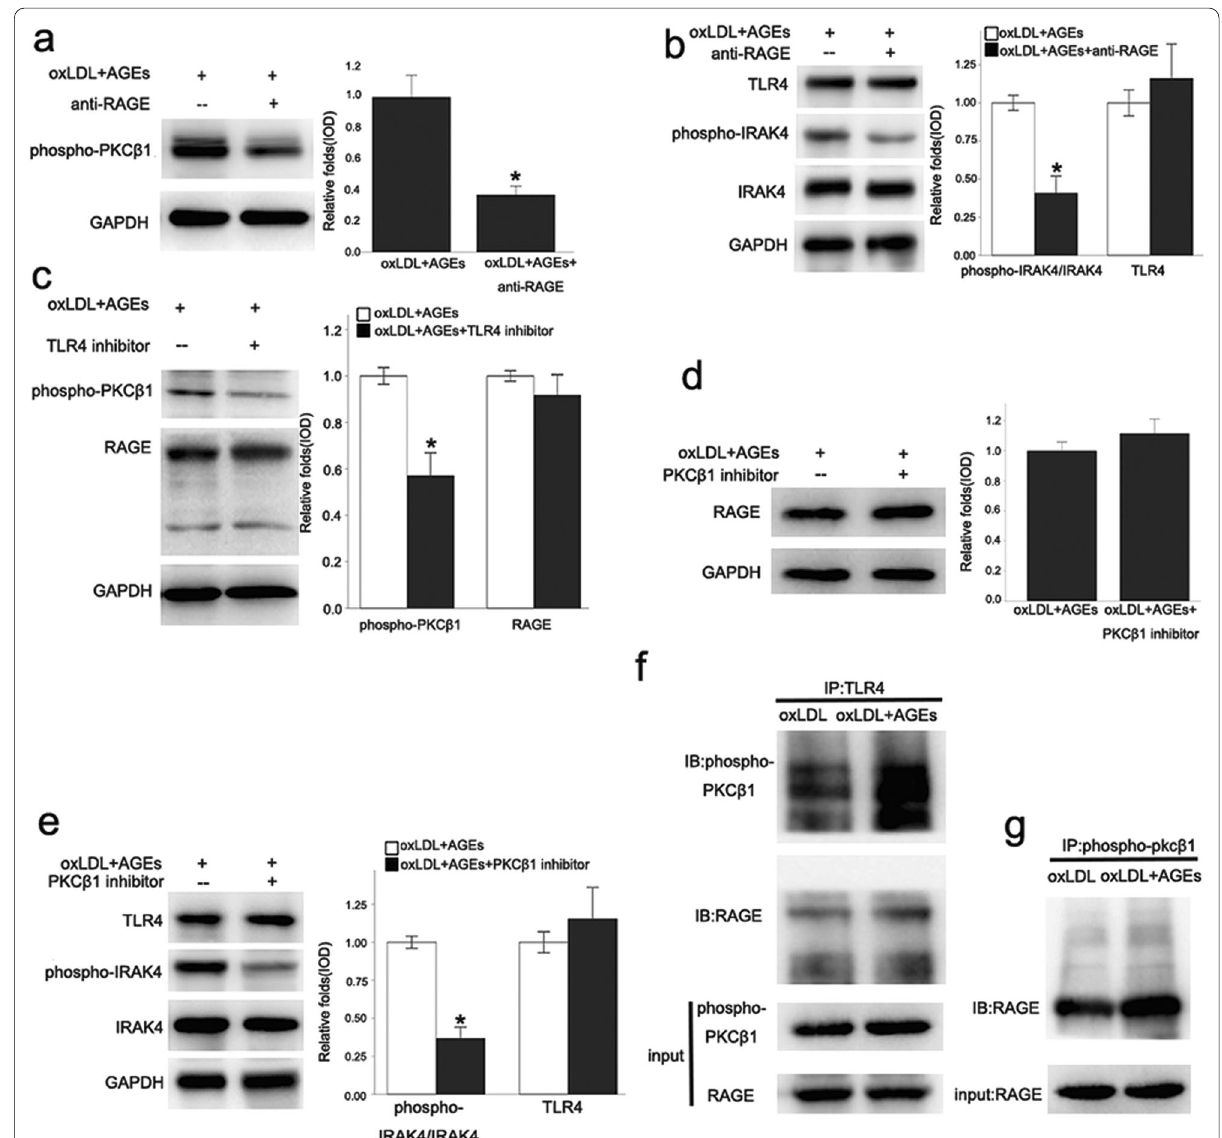
Fig. 5 The relationship among RAGE, TLR4, and phospho-PKCβ 1 . The phosphorylation of PKCβ 1 , induced by oxLDL plus AGEs, was down-regulated by the RAGE neutralization antibody, as well as the phosphorylation of IRAK4, but there was no significant difference in the change in TLR4 ( a , b ). The phosphorylation of PKCβ 1 was decreased in the TLR4 inhibitor group, while RAGE expression was not affected ( c ). TLR4 and RAGE expression in the PKCβ 1 inhibitor intervention group showed no significant differences, but the phosphorylation of IRAK4 was significantly inhibited ( d , e ). Coimmunoprecipitation showed that TLR4 was bound to RAGE and phospho-PKCβ 1 ( f ), while phospho-PKCβ 1 was bound to RAGE ( g ). Values, mean SED; n 3, *p < 0.05 vs. oxLDL AGEs group, oxLDL oxidized low density lipoprotein, AGEs advanced glycation end-products, RAGE Receptor ± = + for advanced glycation end products, PKC protein kinase C, TLR4 Toll-like receptor 4, IRAK4 Interleukin receptor associated kinase